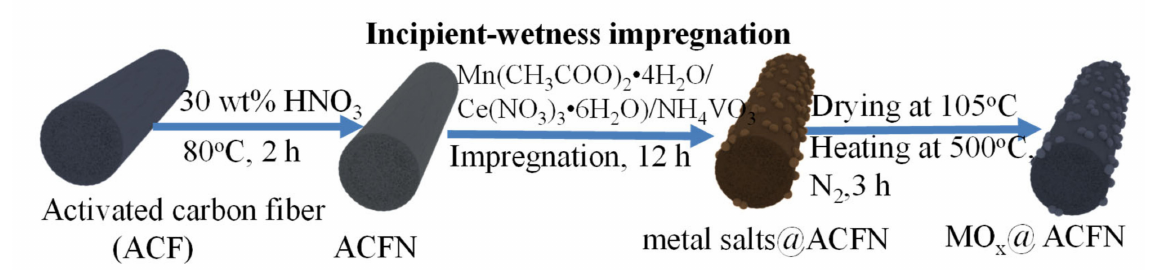
Figure 1. Preparation process of metal oxides@ACFN catalysts via incipient wetness impregnation